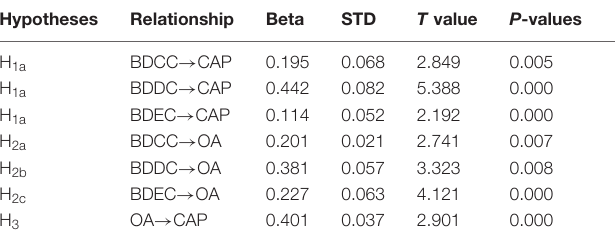
TABLE 4 | Structural model assessment (direct effect results and decision).